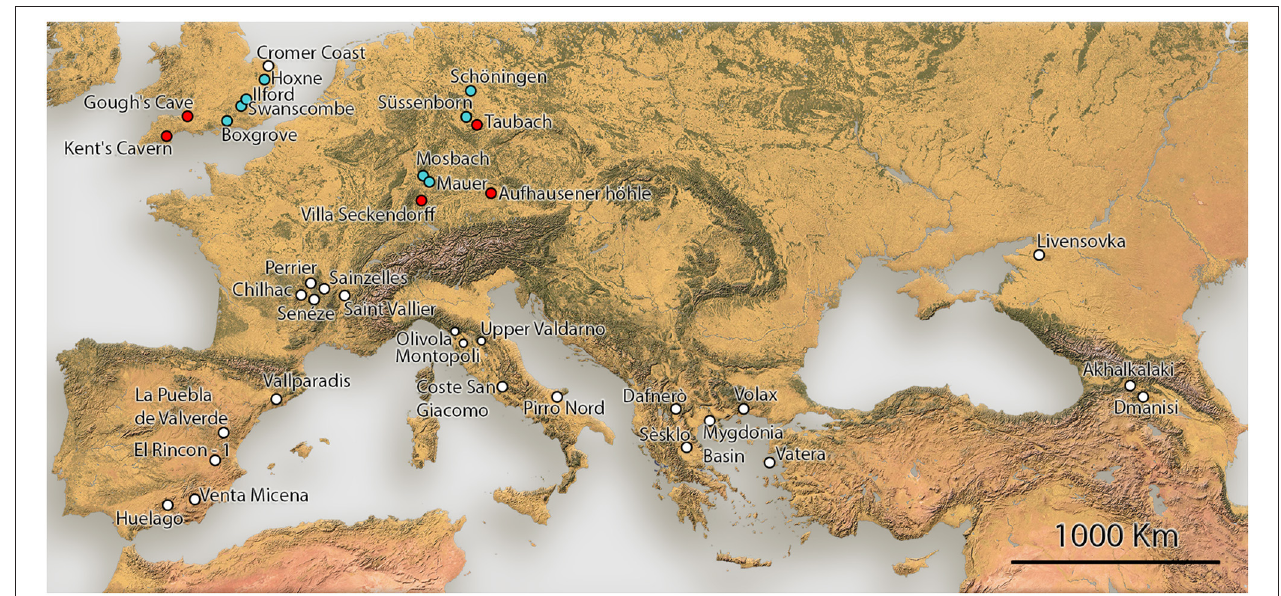
FIGURE 1 | Map of Early to Late Pleistocene Equus localities included in this